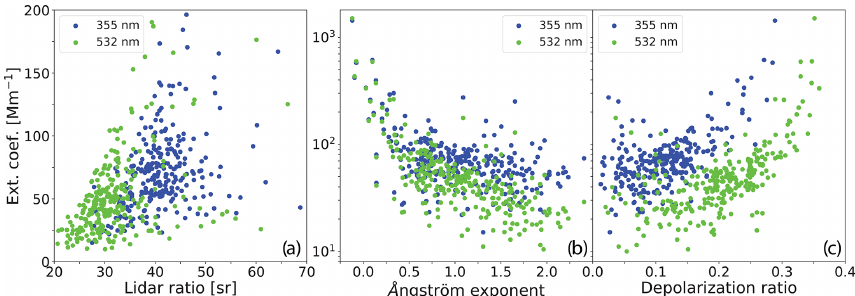
Figure 6. Correlation between the particle extinction coefficient at 355 and 532nm and (a) the 355 and 532nm particle lidar ratios, (b) the extinction-related Ångström exponent (355–532nm spectral range; blue and green show the same data set on the x axis), and (c) 355 and 532nm particle linear depolarization ratios. All individual nighttime observations of the 1.5-year campaign are considered.